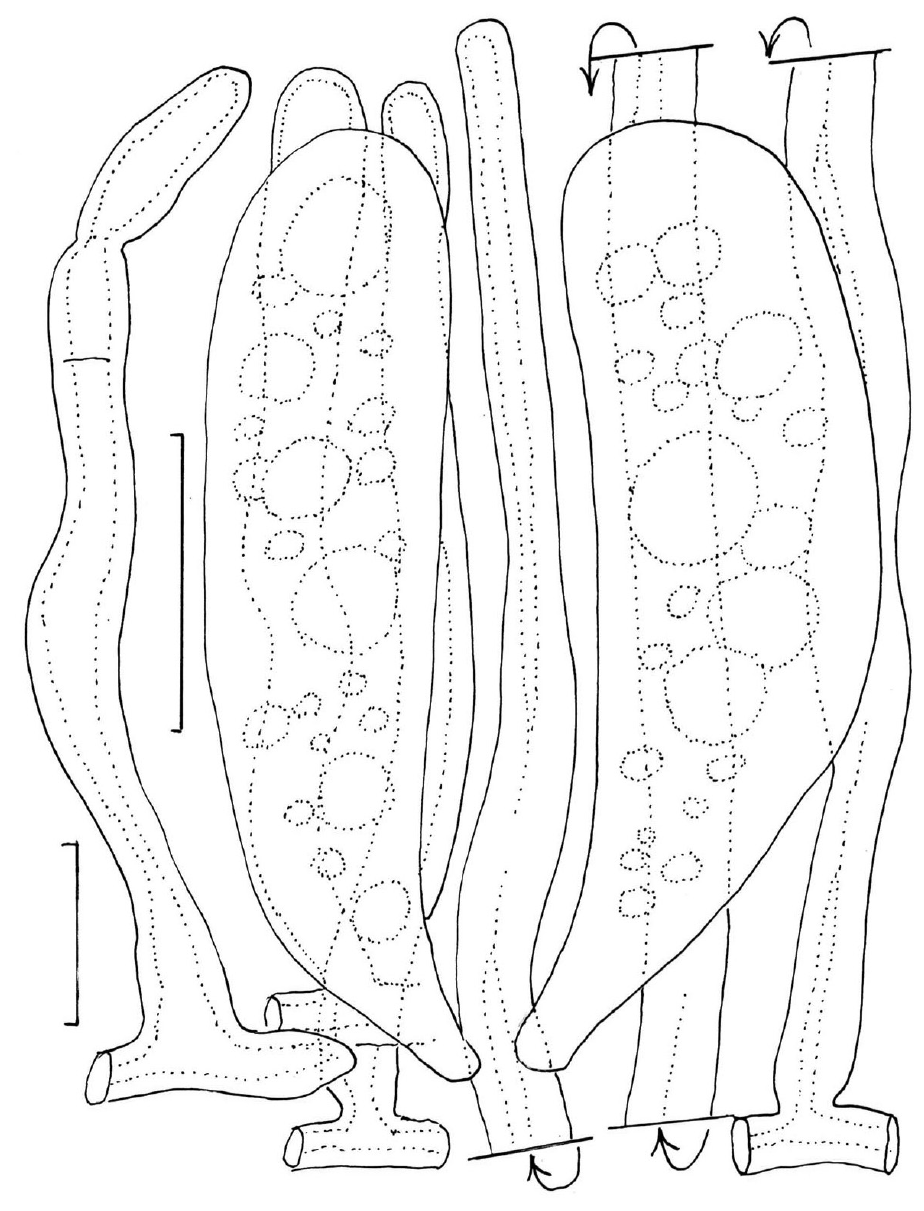
Figure 69. Mycetinis salalis . A Basidiospores. B Caulocystidia: left from upper stipe, right from lower stipe. Standard bars: A = 5 µm, B = 20 µm. TFB 5724 (TENN 52572). Basidiospores of My. salalis are significantly longer than those of My. copelandii . Collection TENN-F-55408-TFB 8084 (morphologically My. copelandii ) is character- ized by appropriately shorter spores but its ITS sequence is essentially congruent